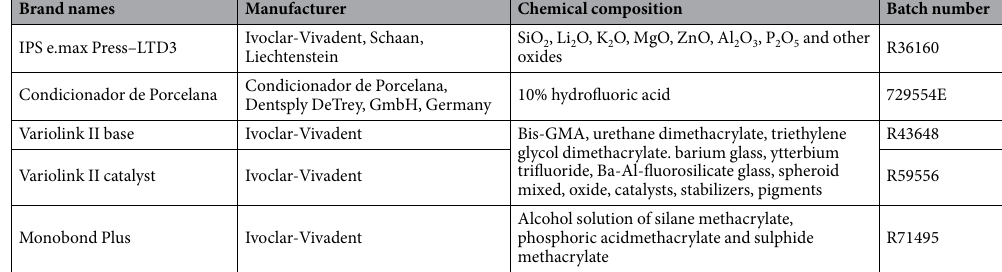
Table 1. Brand names, manufacturers, chemical compositions and batch numbers of the materials used in the present study. Abbreviations. Bis-GMA: bisphenol A-glycidyl